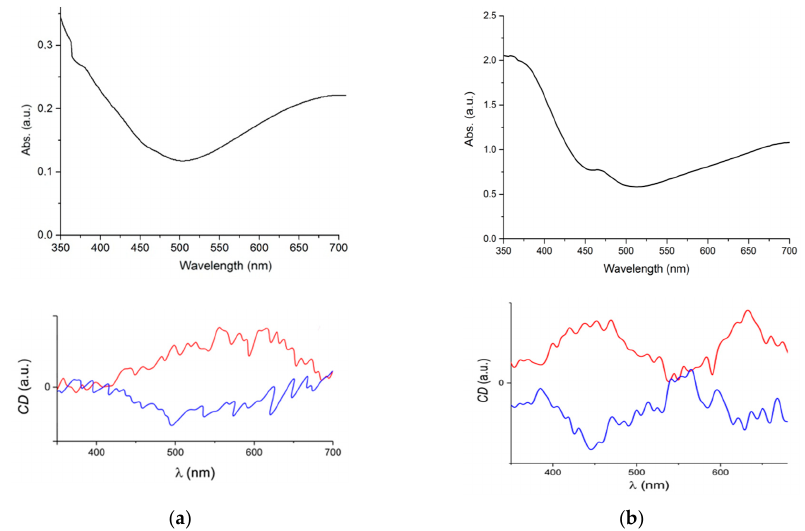
Figure 3. CD signal for compounds VCr1 ( a ) and VCr2 ( b ): D enantiomer (red line), L enantiomer (blue line).